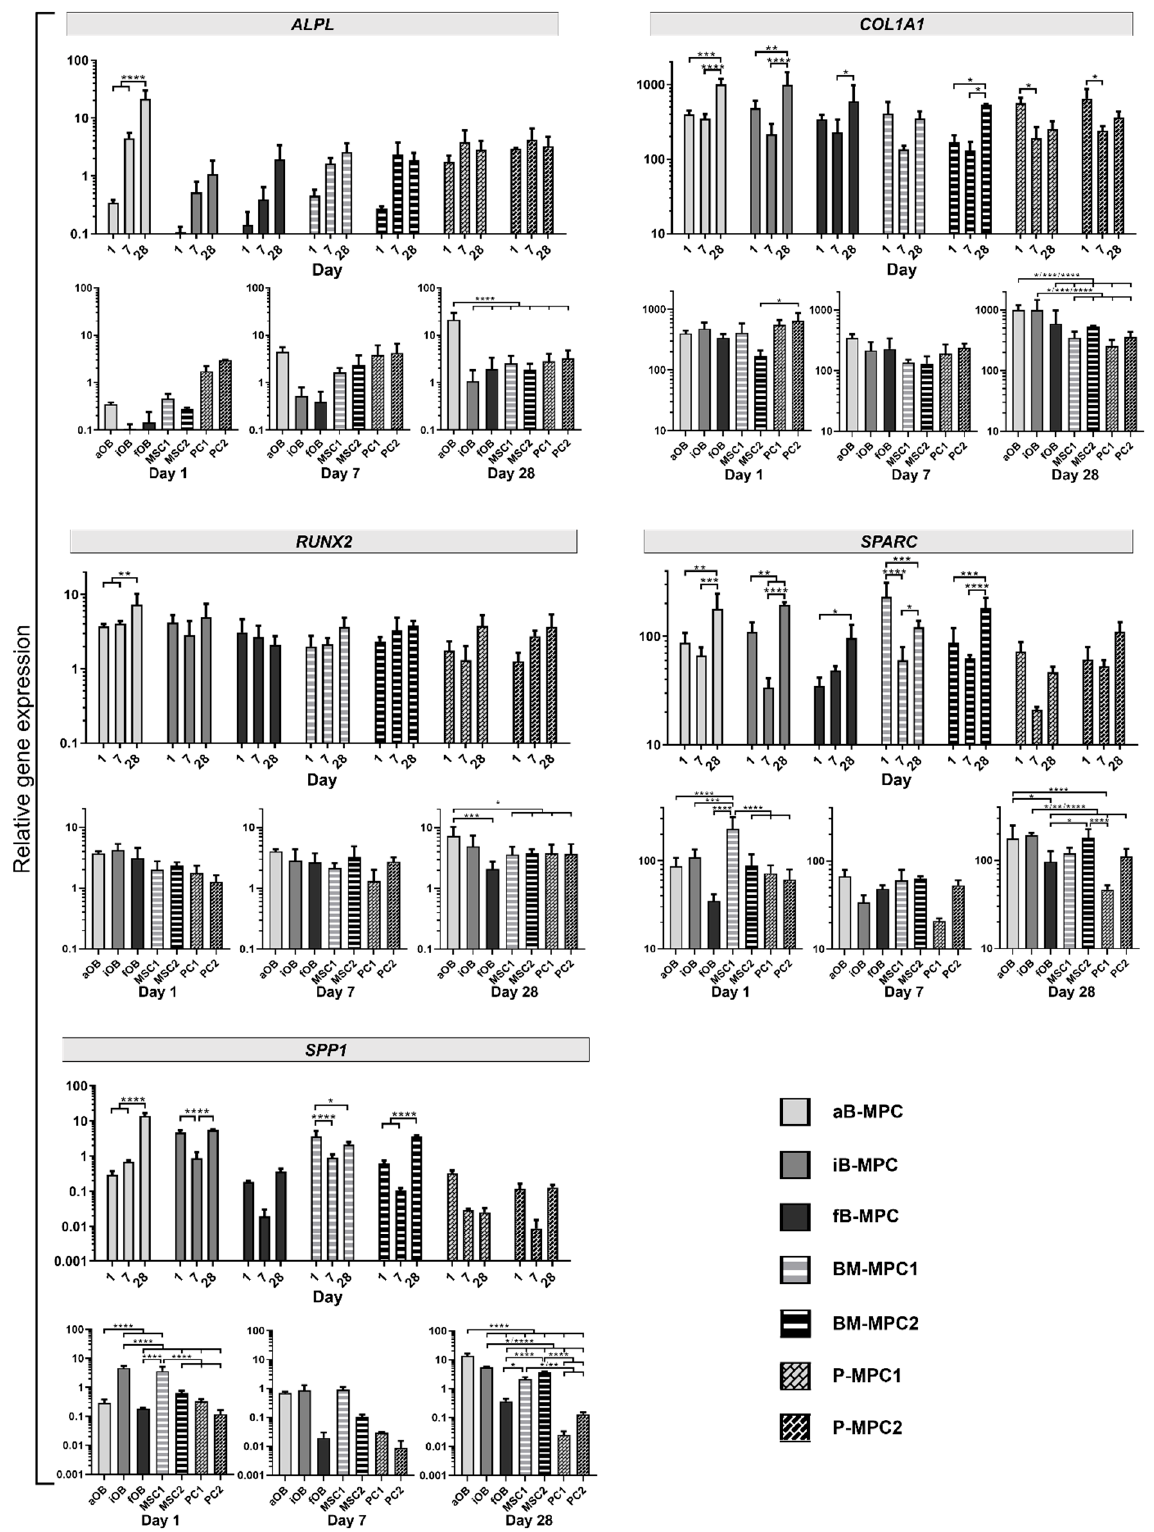
Figure 5. Gene expression analysis. Relative gene expression of differentiation markers ALPL (alkaline phosphatase), COL1A1 (collagen type I alpha chain), RUNX2 (Runt-related transcription factor 2), SPARC (secreted protein acidic and cysteine rich) and SPP1 (secreted phosphoprotein 1) in bioprinted constructs on days 1, 7, and 28, normalized to TATA-box binding protein (TBP) expression. Asterisks mark statistically significant differences in the data. Data are presented as mean ± standard deviation. n = 3.